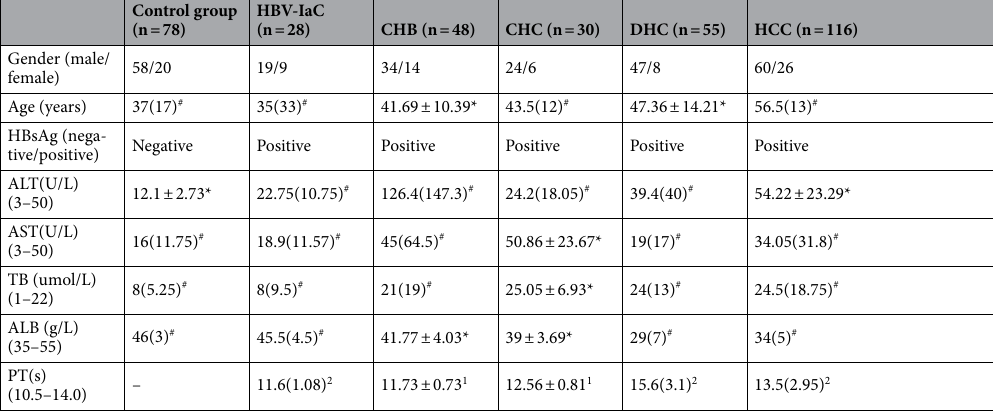
Table 1. Demographic information and liver function of study population. *Data as normal, described as: mean +/−standard deviation, P > 0.1; #data for the non-normal, described as: the median (interquartile range), P < 0.1;– : not to do.